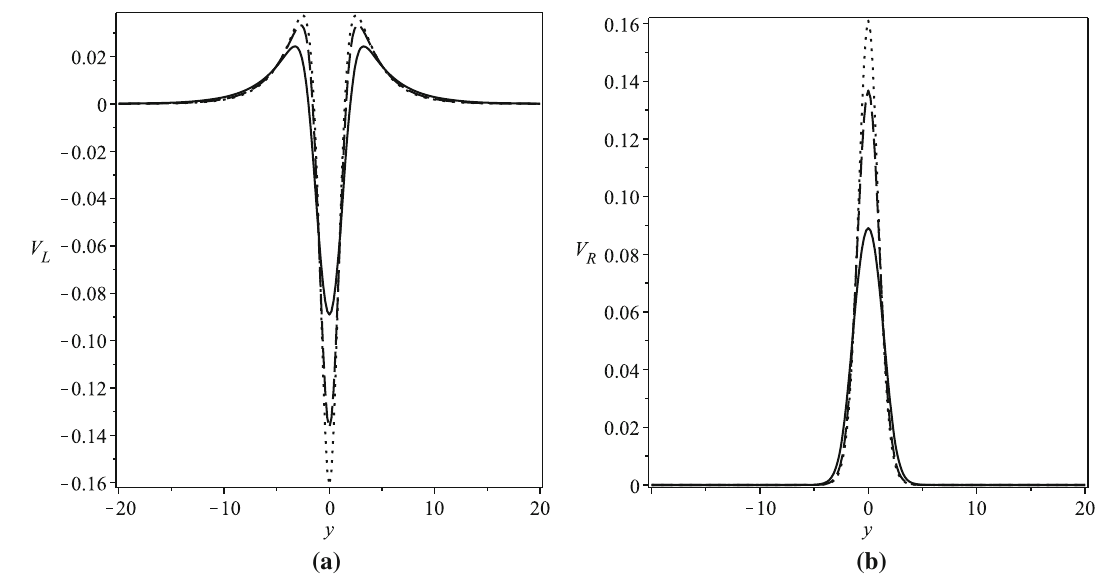
Fig. 7 The profile of the potentials a V L ( y ) and b V R ( y ) for a = 1 (solid line), a = 2 (dashed line), a = 5 (dotted line), η = 1